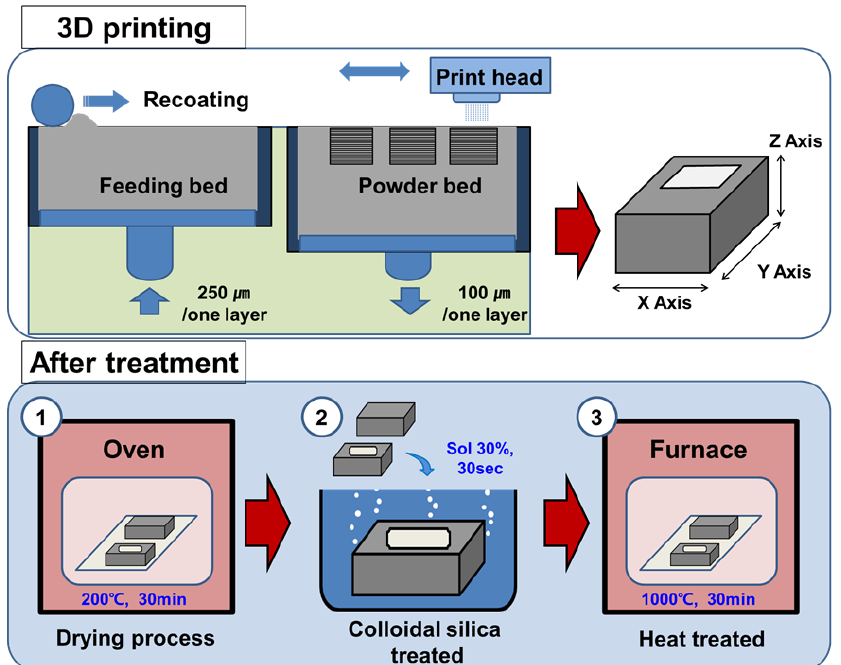
Figure 1. Mold production through powder bed 3D printing and post-treatment process of colloidal silica ➀ organic matter and moisture removal of green body (G), ➁ colloidal silica treatment (GC) ➂ heat treatment (GCH).